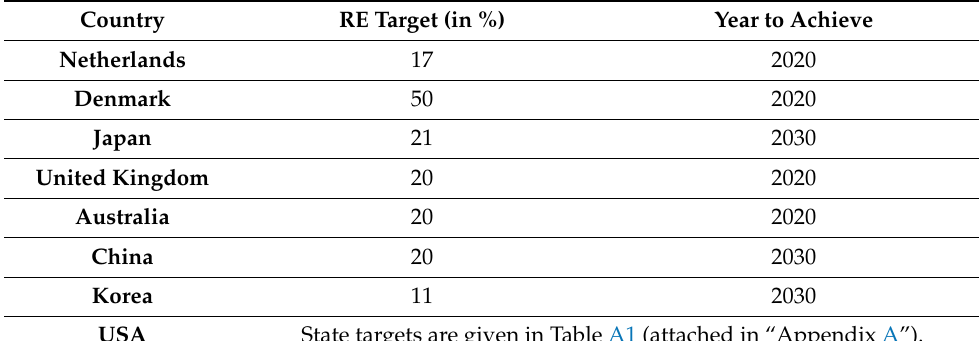
Table 2. RPS targets different countries. Country RE Target (in